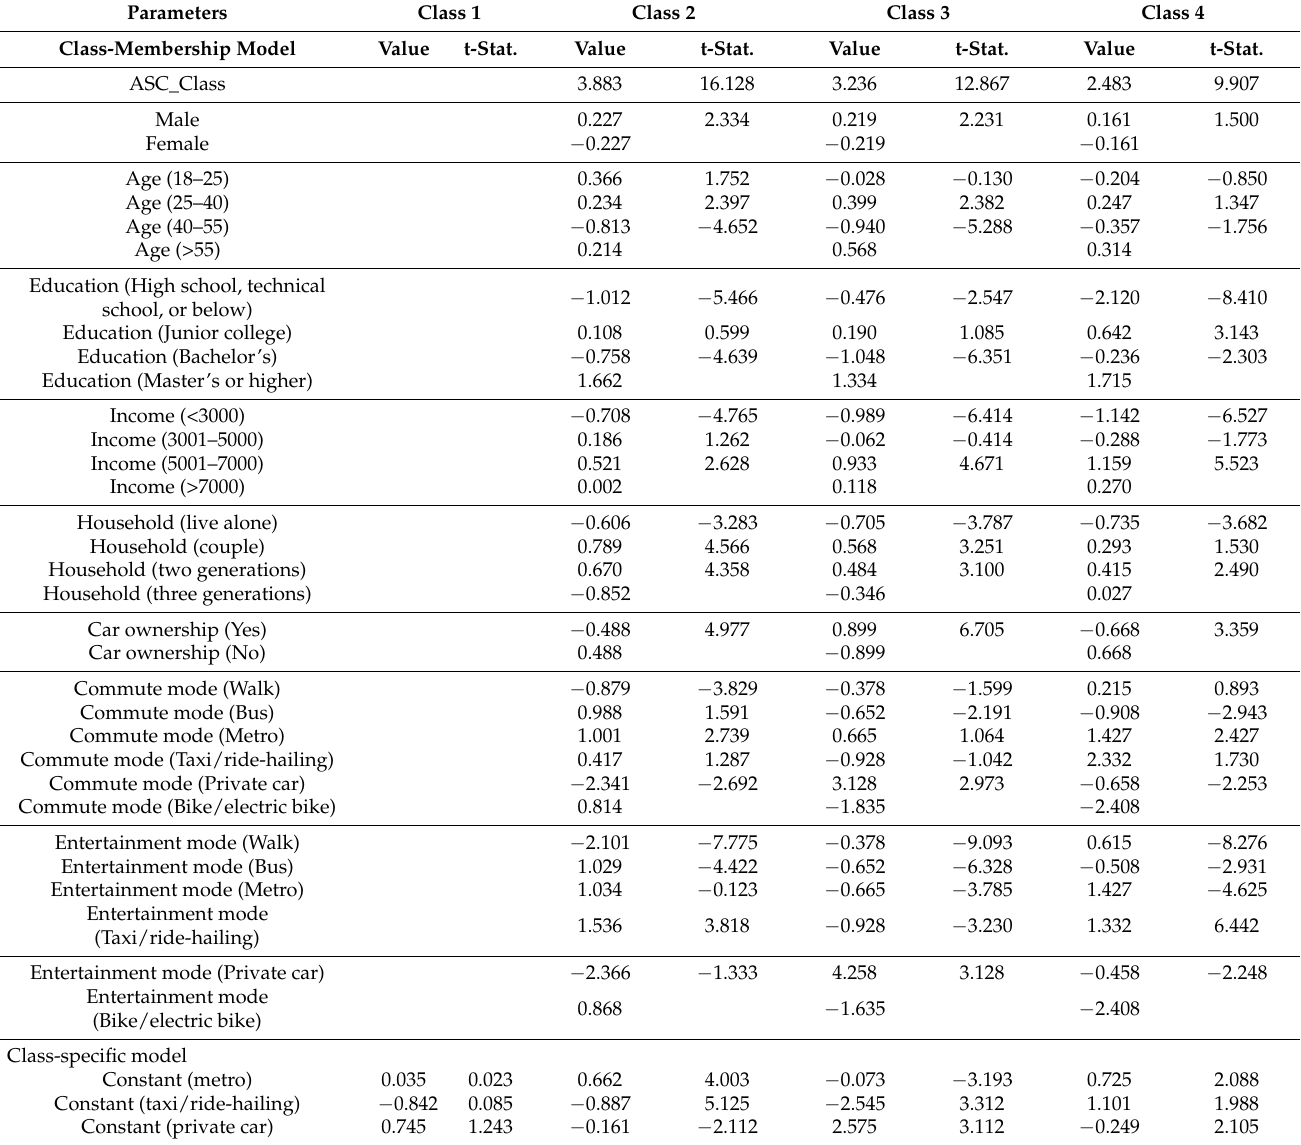
in the following contexts. In our estimation results, classes 2, 3, and 4 contain 38.60%, 44.68%, and 12.46% of the respondents, respectively. The pseudo-R-squared value is 0.2878, which satisfies the requirements [50,54]. Based on the class-membership posterior characteristics for each class is shown in Figure 5. Table 4. Estimation results of the latent class analysis in Wave